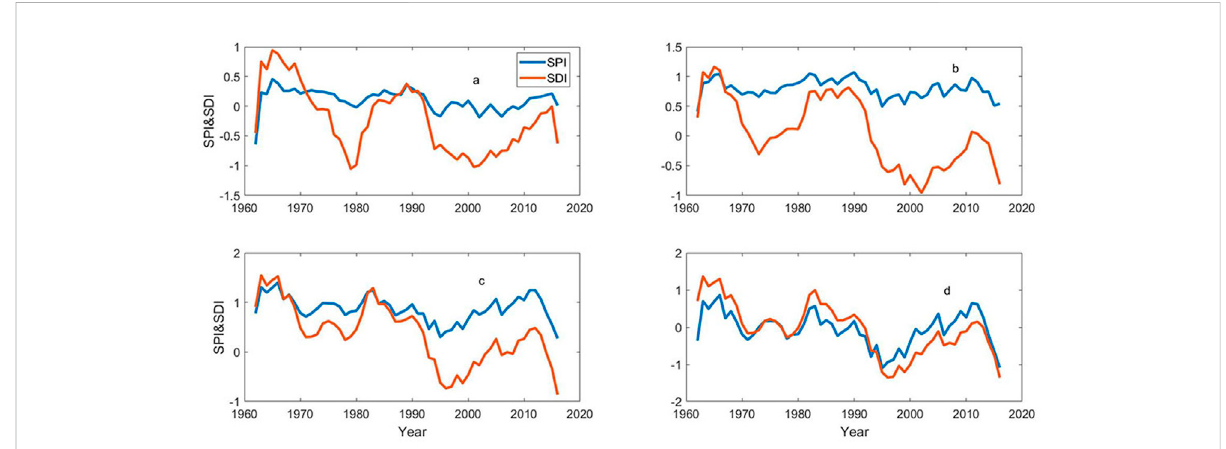
FIGURE 8 MovingaverageoftheSPIandtheSDIatdifferenttimescales. (A) isa3-monthtimescale, (B) isa6-monthtimescale, (C) isa9-monthtimescale, and (D) is a 12-month time scale.